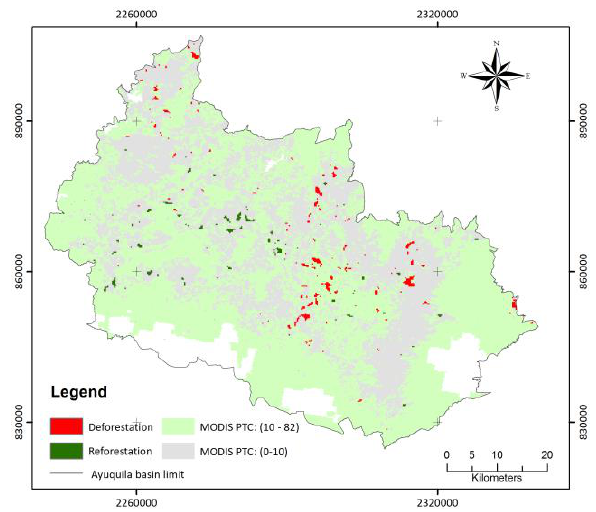
Figure 1. Forest change patches for Ayuquila Basin produced by annual MODIS PTC data (2000 – 2010) and presented with MODIS PTC 2000 as background.